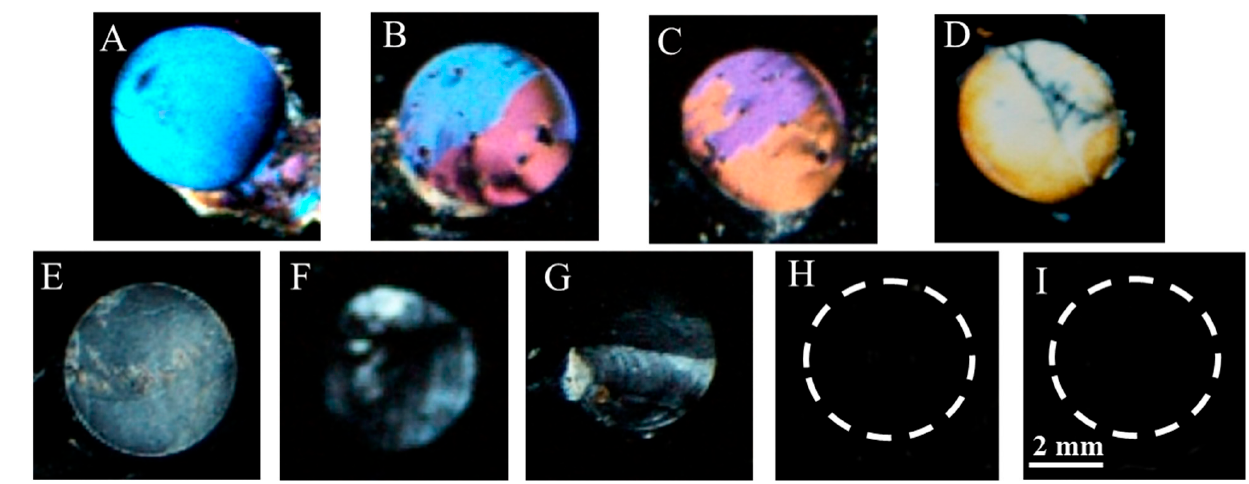
Figure 6. Optical images of LCs supported on B40t77 aptamer (8 µg/mL) immobilized DMOAP-coated glass surfaces after addition of different concentrations of gp-120: ( A ) 8, ( B ) 6, ( C ) 4, ( D ) 2, ( E ) 1, ( F ) 0.5, ( G ) 0.2, ( H ) 0.1 and ( I ) 0 µg/mL, respectively.